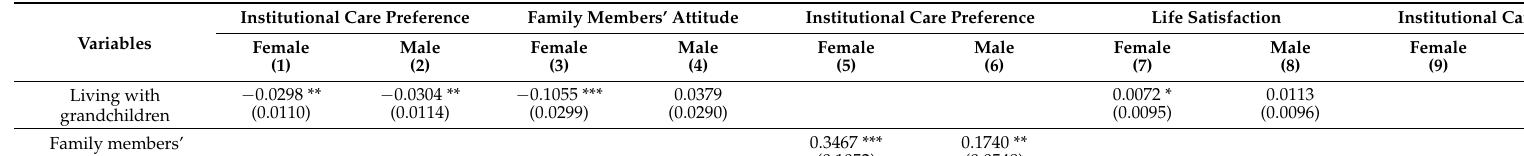
Table 4. Marginal effect on heterogeneous effects of gender: determinants of institutional care